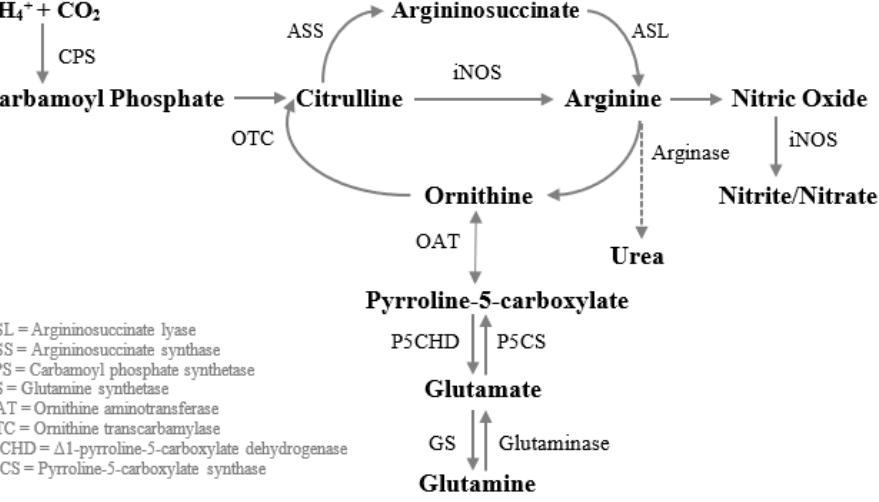
Figure 3. Metabolism of glutamine to arginine in human macrophages. Carbamoyl phosphate when combined with ornithine via OTC is converted to citrulline. Then citrulline is transformed into argininosuccinate and then into arginine by the action of ASS and ASL, respectively. Arginine can then be turned into nitric oxide or ornithine. Ornithine can be transformed into glutamine, and vice versa, via glutamate and pyrroline-5-carboxylate.